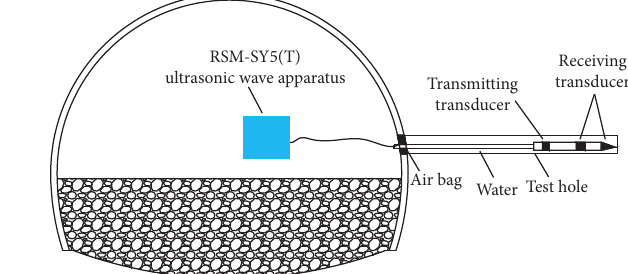
Figure 3: Schematic of single-hole ultrasonic test.